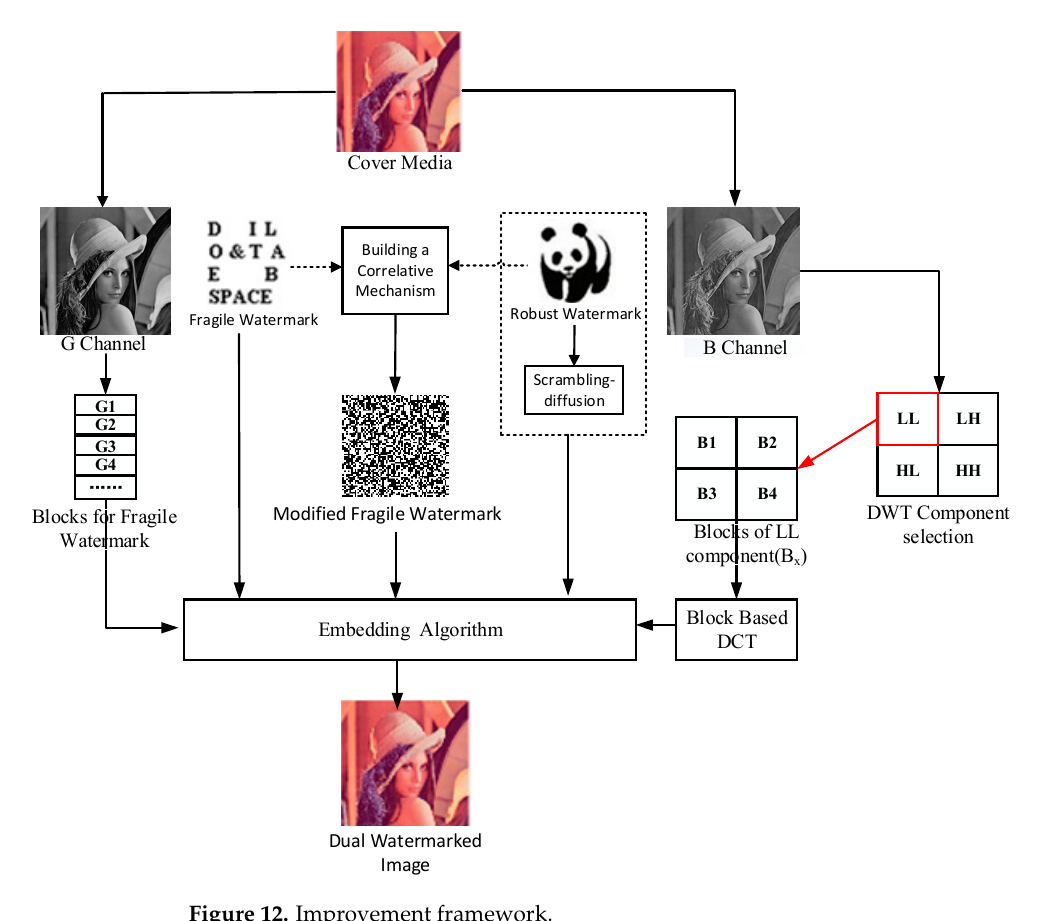
Figure 12. Improvement framework. Algorithm 7: Improved Double Watermark Algorithm